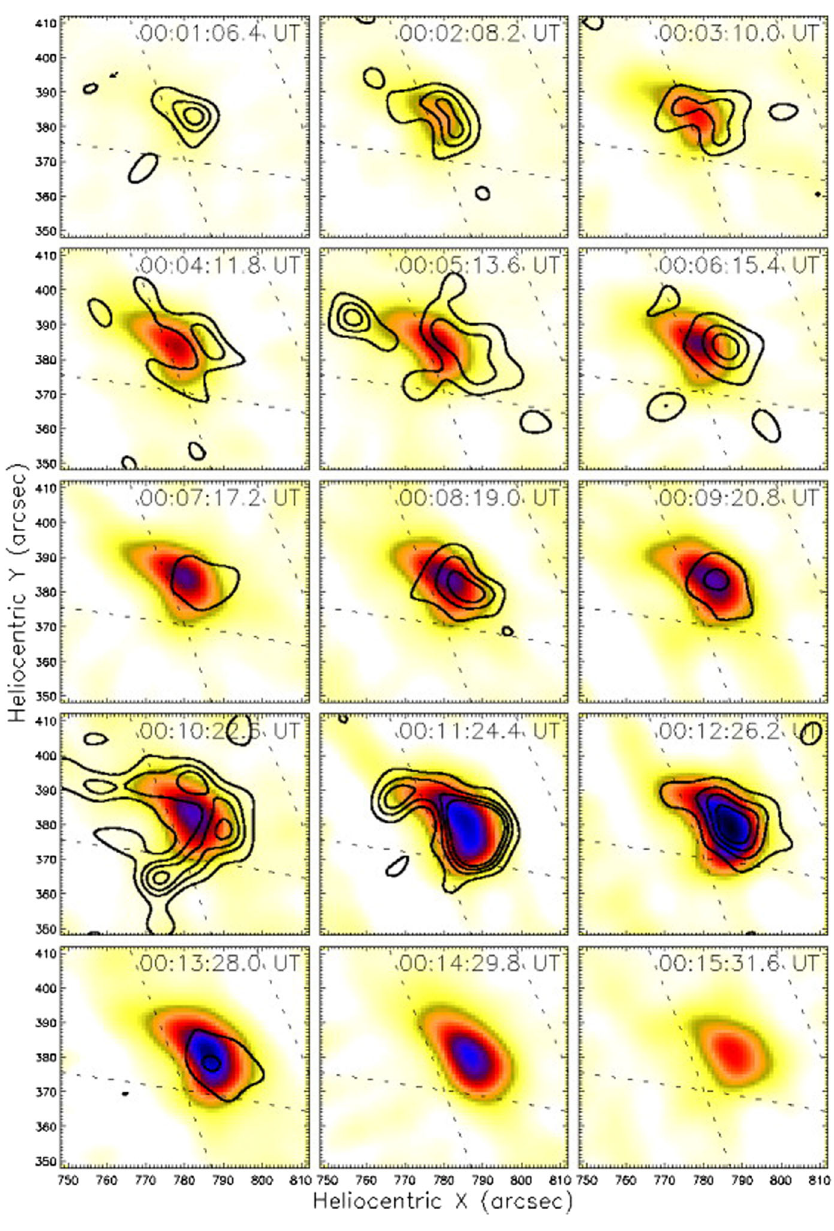
Fig. 15 RHESSI observations at 6–12 keV ( colors ) and 25–50 keV ( contours ) of a coronal flare. The high- energy photons have a non-thermal origin and originate near the loop-top without pronounced footpoints. Image reproduced with permission from Veronig and Brown (2004), copyright by